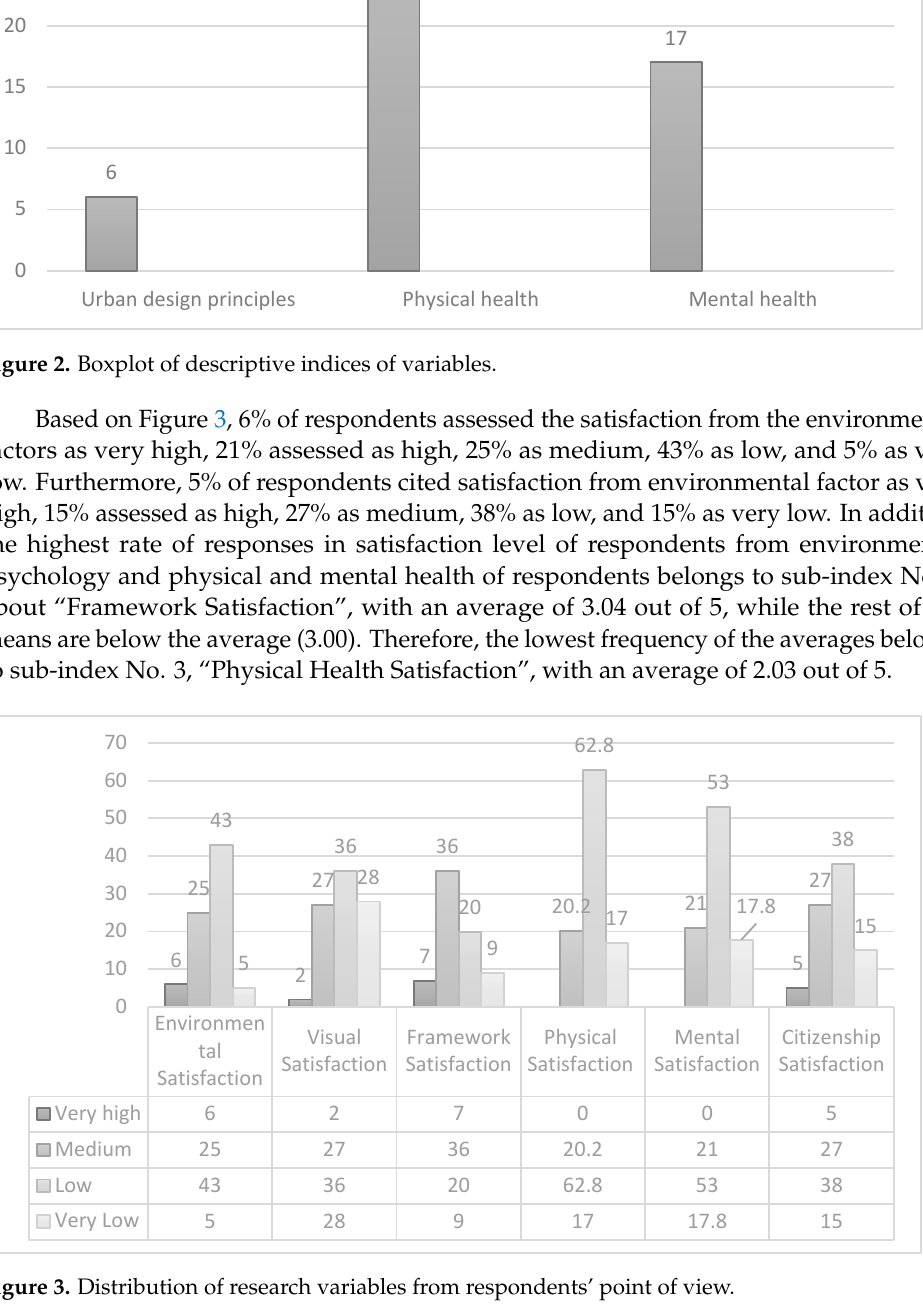
Table 3. Pearson correlation among variables with fit lines.